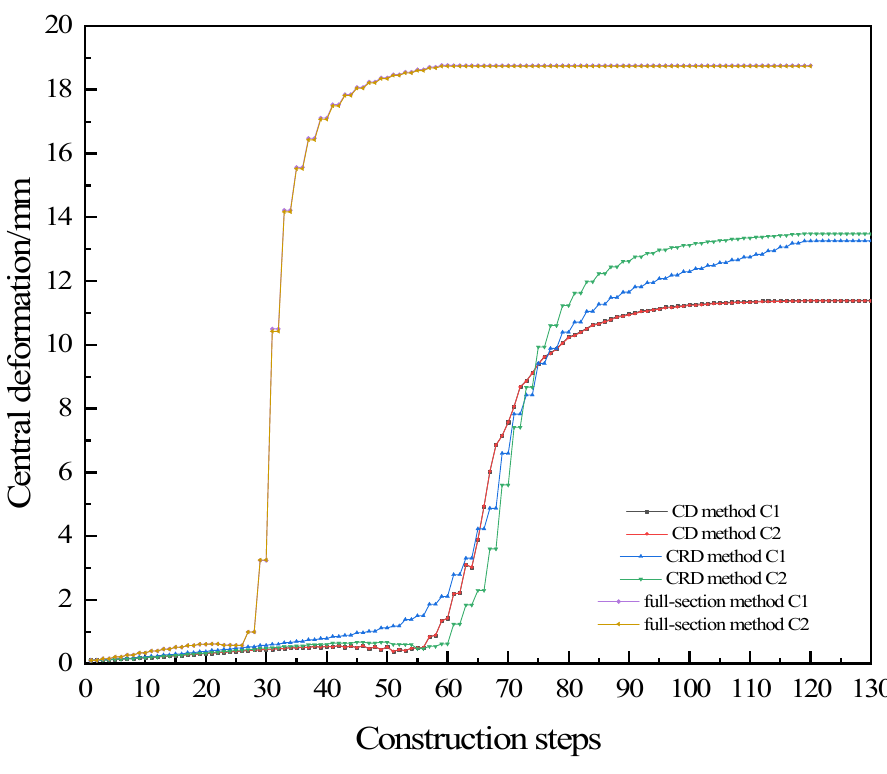
Figure 10. Deformation diagram of the secondary lining arch bottom.